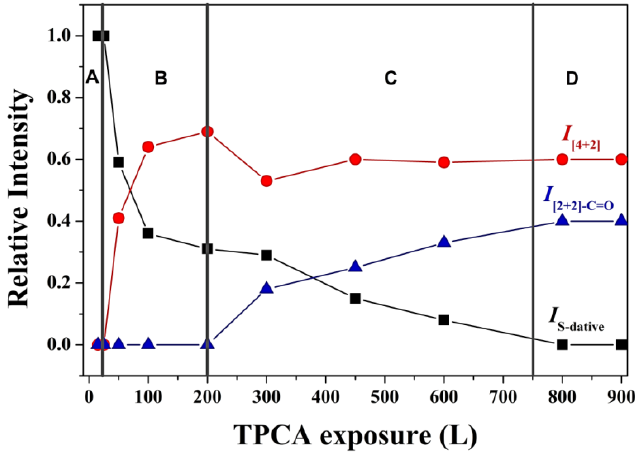
Table 1. Relative intensities of the three TPCA adsorption structures on the Ge(100)-2 × 1 reconstructed surface at room temperature, as a function of TPCA exposure. I and I indicate the relative intensity at each [2 + 2]-C=O